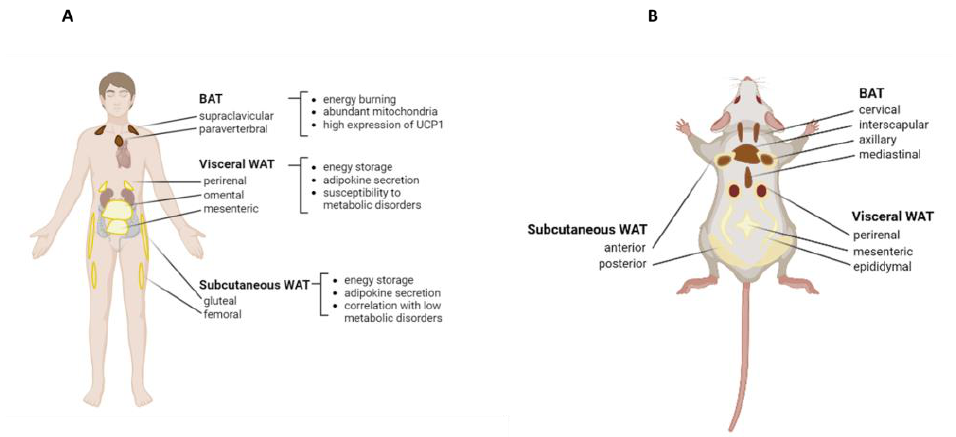
Figure 1. Adipose tissue distribution. ( A ) Distribution of WAT and BAT in humans. Both vWAT and sWAT possess abilities to store energy and secrete various adipokines. The sWAT is distributed throughout the body under the skin, while the vWAT surrounds the intra-abdominal organs. Located around the shoulders and ribs, BAT contributes to heat generation through the expression of UCP-1. ( B ) As compared to adult humans, the BAT in adult mice is well developed and easy to observe. The gonadal WAT depots located around the ovaries and the testes are studied as a model of vWAT. The figure was created with Biorender.com.(https://www.biorender.com/ Accessed on 16 May